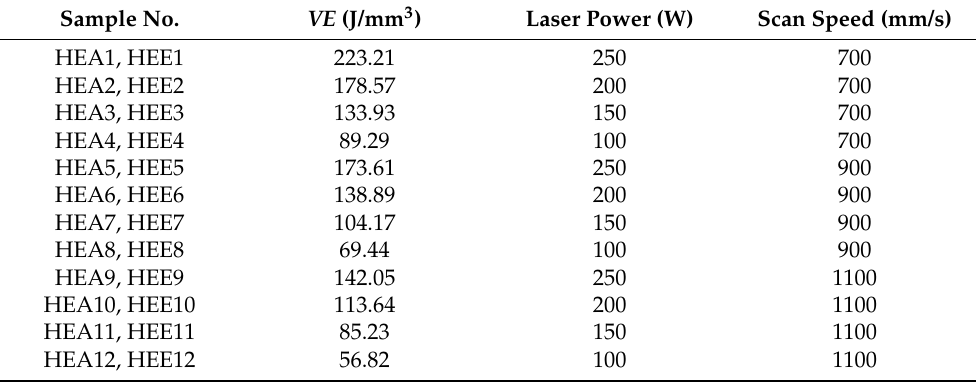
Table 2. Selective laser melting (SLM) process parameters and sample labels. VE : volume laser density. HEA: pre-alloyed powder samples. HEE: elemental powder samples. Sample No.